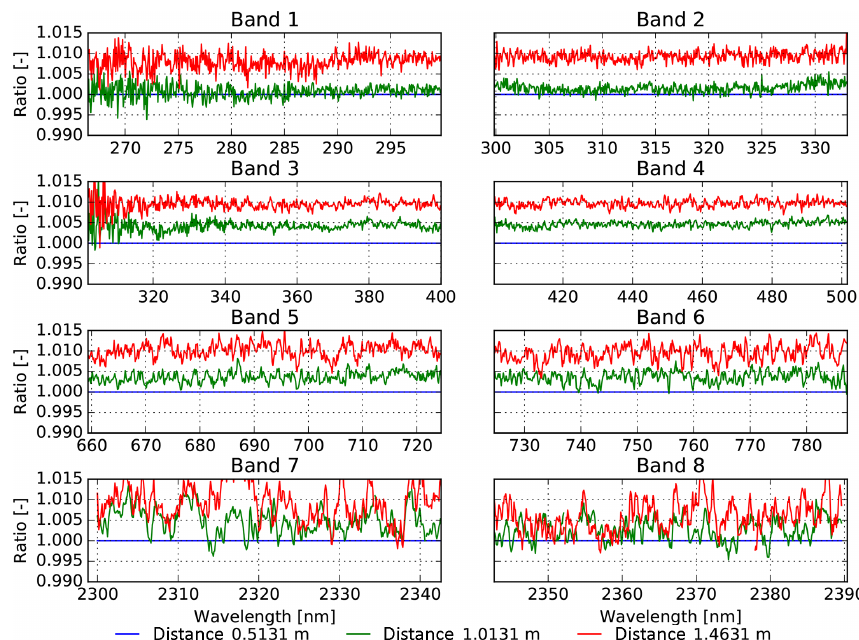
Figure 11. Results obtained for bands 1–8 for different lamp–diffuser distances d 1 , d 2 , or d 3 , for lamp FEL1, diffuser DIF1, and cradle rotation angle 0 ◦ . The radiance signals were multiplied by the square of the distance and then divided by the ABSRAD result obtained for distance d 1 ; thus, roughly unity results are expected for distances d 2 and d 3 . Results obtained for distance d 2 (green lines) are generally 0.1%– 0.5% higher than expected, whereas for distance d 3 (red lines) discrepancies up to 1% are obtained in all detectors. The high-frequency component visible in all plots is not measurement noise but diffuser